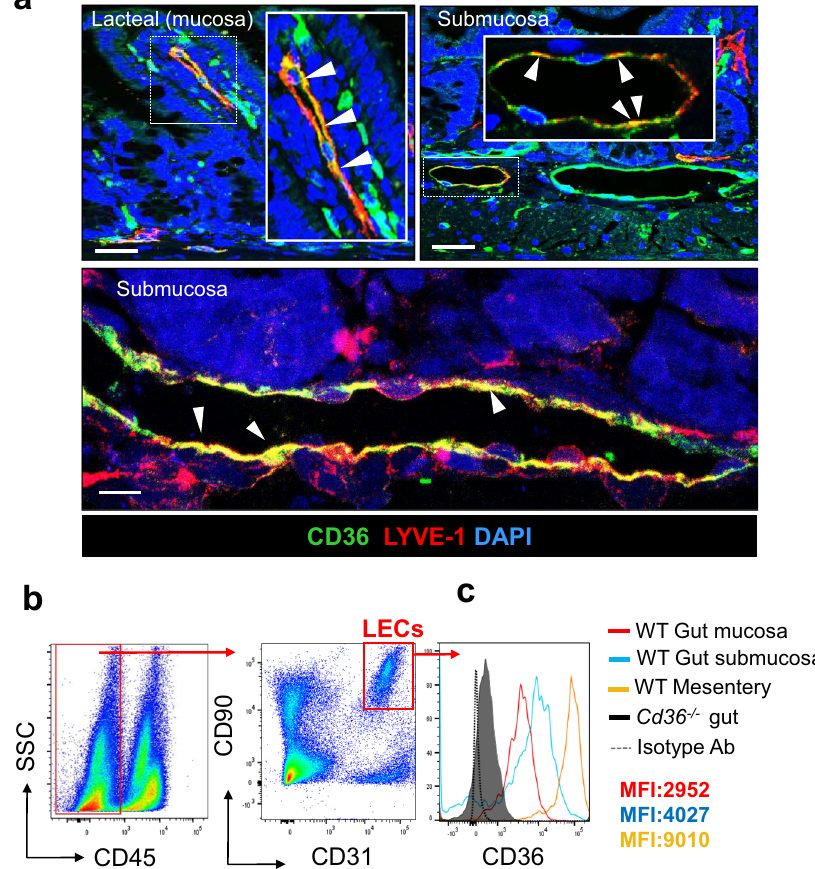
Fig. 1 Cd36 expression in gut and mesenteric lymphatic vessels. a Representative staining for CD36 (green) and its colocalization with lymphatic vessel endothelial hyaluronan receptor 1, LYVE-1, (red) in lymphatic capillaries (lacteals) and in collecting vessels within the submucosa in C57BL/6 wild-type (WT) mice. Nuclei stained with DAPI (blue). Images were acquired using a Zeiss LSM 880 Airyscan Confocal microscope, ×20 and ×40 objective. Scale bar: 50 μ m (top panel) and 10 μ m (bottom and panel). b Flow cytometry to identify intestinal and mesenteric lymphatic endothelial cells (LECs) (CD45 – CD90.2 + CD31 + ). c CD36 expression in LECs isolated from gut mucosa (red) and submucosa (blue), and the mesentery (orange) in WT mice. Jejunum from Cd36 − / − mice and IgG isotype control antibody used at the same concentration as CD36 antibody were included to document CD36 antibody speci fi city. Mice ( n = 6) used in ( a – c ) are 12-week old. SSC side scatter, MFI mean fl uorescence intensity, CD cluster of differentiation. Data are representative of three experiments with n representing the number of mice per